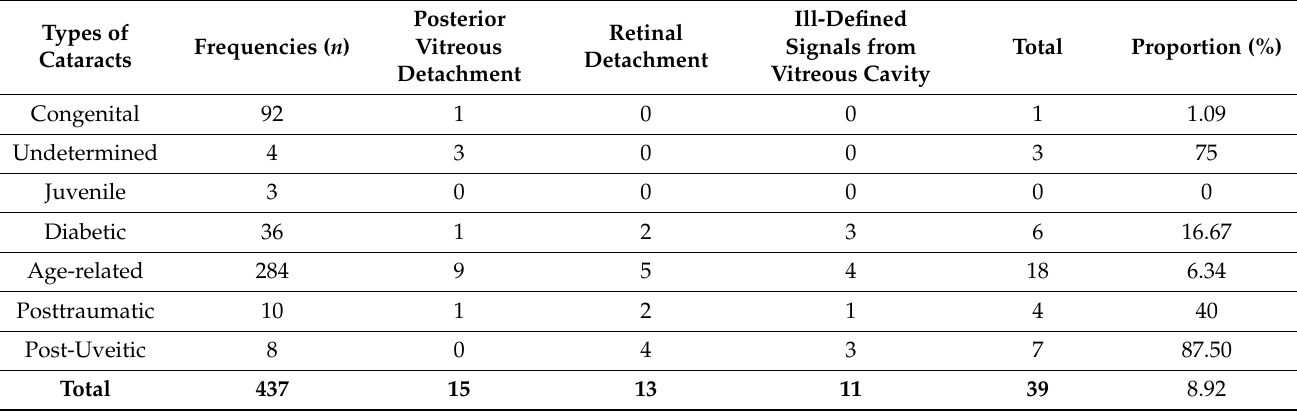
Table 2. Posterior Segment pathology variations according to the etiologies of cataracts.